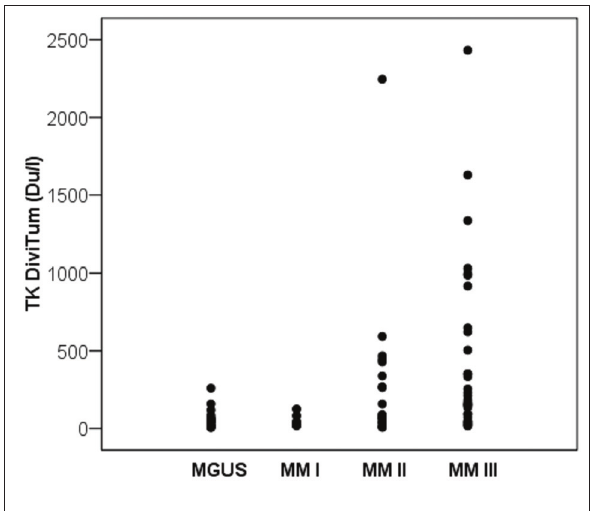
Fig. 3. Significantly higher TK values were in the group of patients with MM (stages I, II or III) than in those with MGUS. The median values obtained by DiviTum™ were 47.0 and 152.5 in MGUS and MM, respectively ( P =